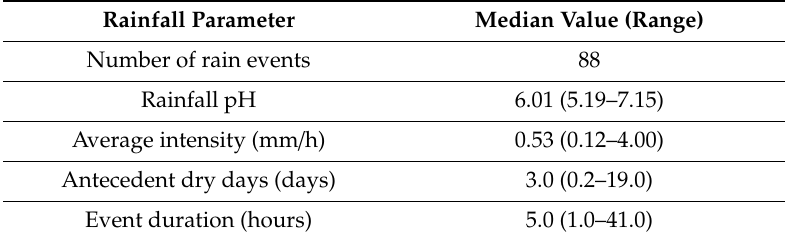
Table A9. Summarized rainfall event characteristics for the year